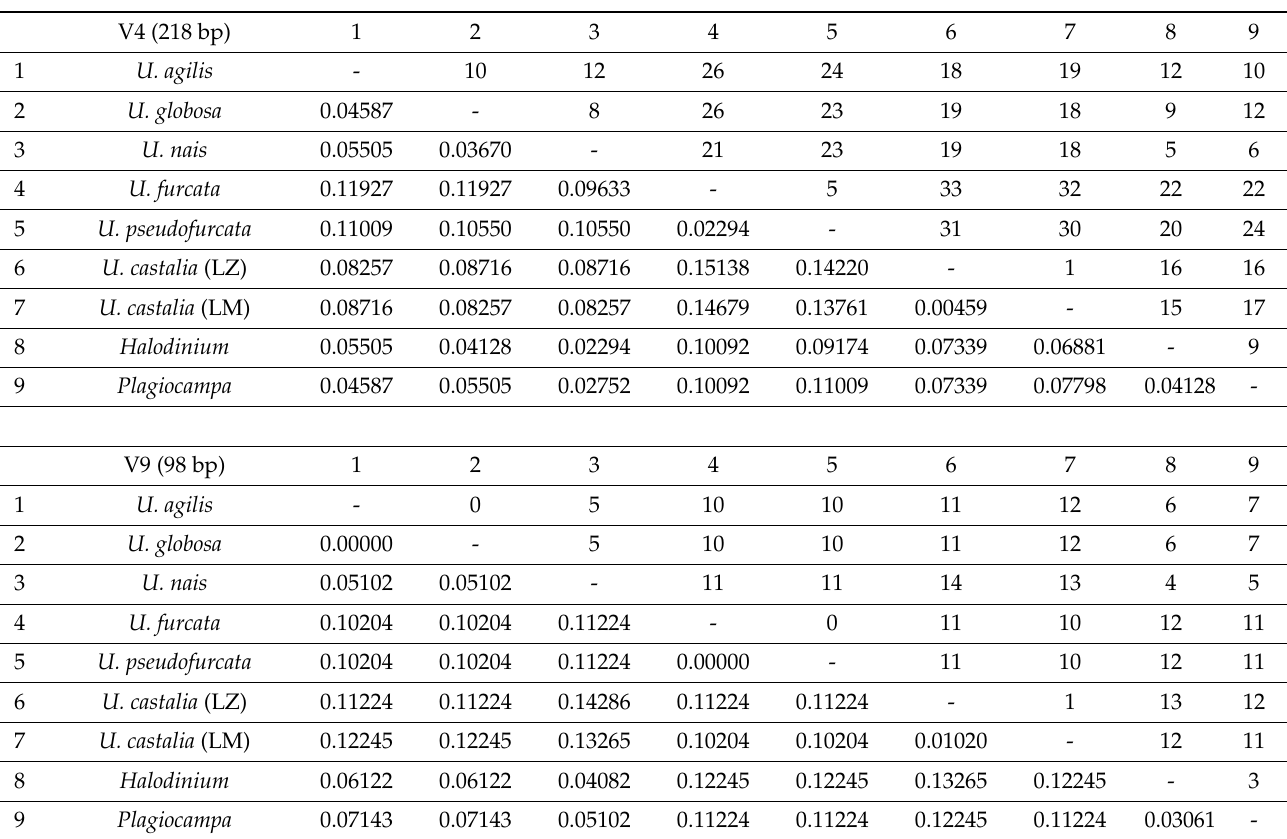
Table 1. Pairwise comparison of V4 and V9 region among the Urotricha species. Bottom left: uncor- rected p-distance matrix calculated with PAUP version 4.0a169, upper left: number of base differences in pairwise